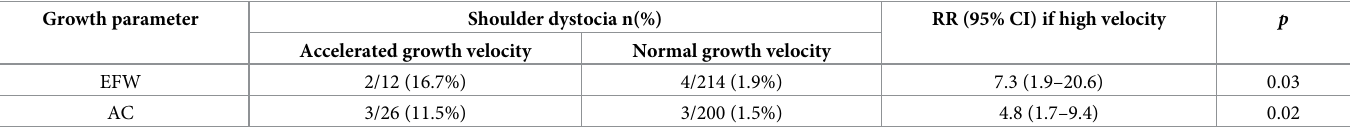
Relative risks (RR) calculated among infants born vaginally, with EFW � 95 th centile at 36-week ultrasound scan. AC = abdominal circumference; EFW = estimated